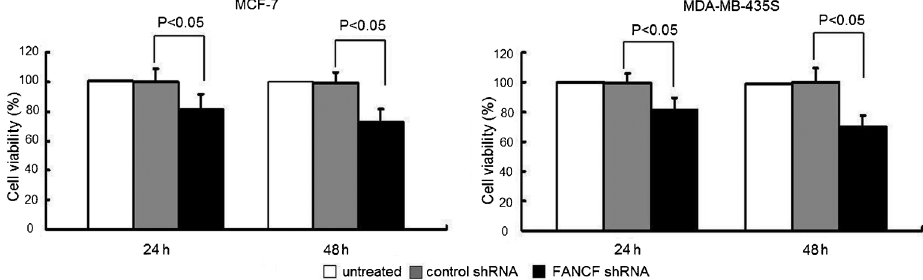
Figure 2. FANCF shRNA inhibits cell proliferation in MCF-7 and MDA-MB-435S cells. Cells were transfected with FANCF shRNA and control shRNA for 24 and 48 h. Cell viability was determined by the CCK-8 kit. Data are reported as means±SD of three independent experiments in triplicate. ANOVA followed by the post hoc test was used for statistical analyses.